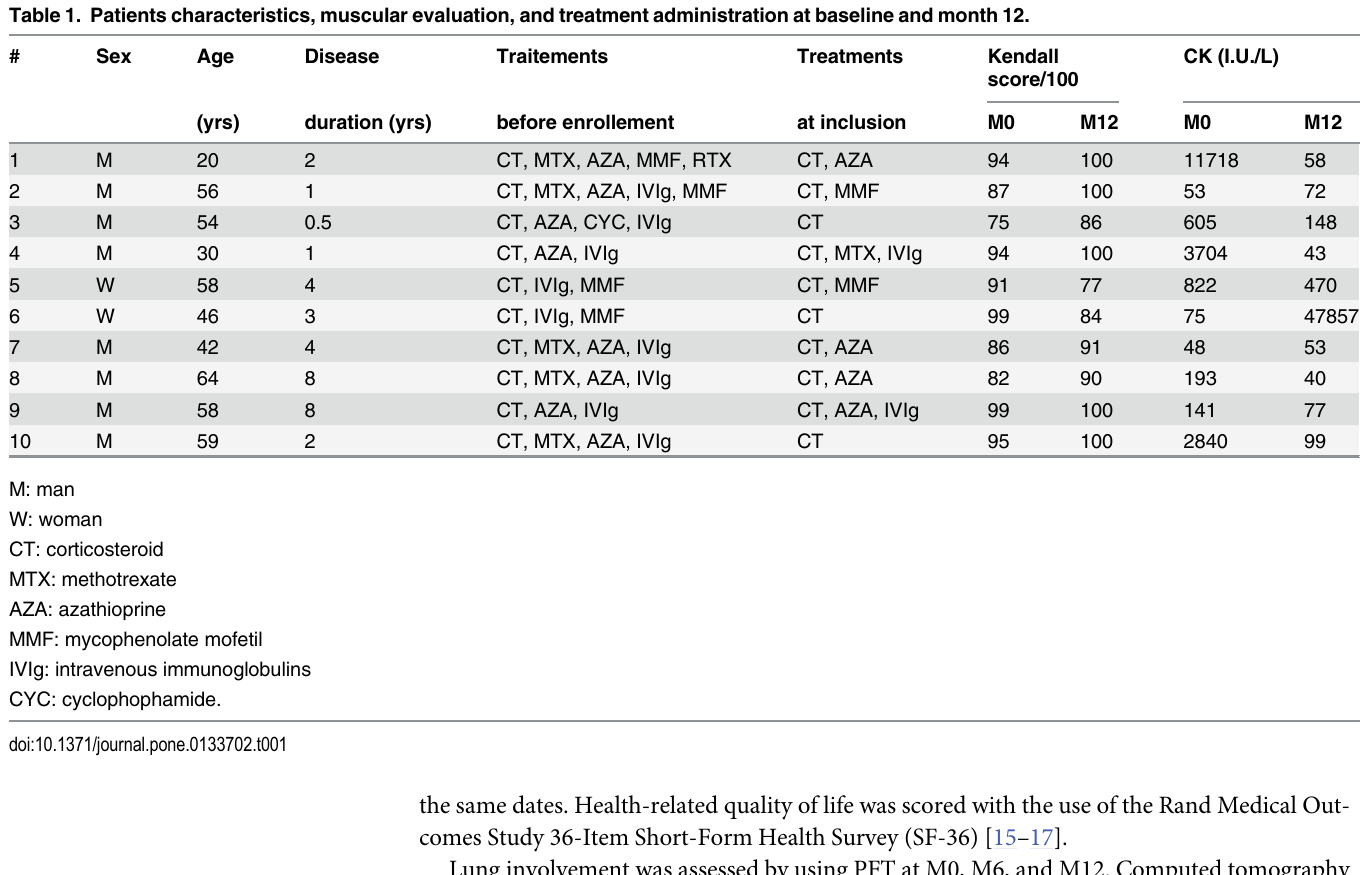
the same dates. Health-related quality of life was scored with the use of the Rand Medical Out- comes Study 36-Item Short-Form Health Survey (SF-36) [15 – 17].